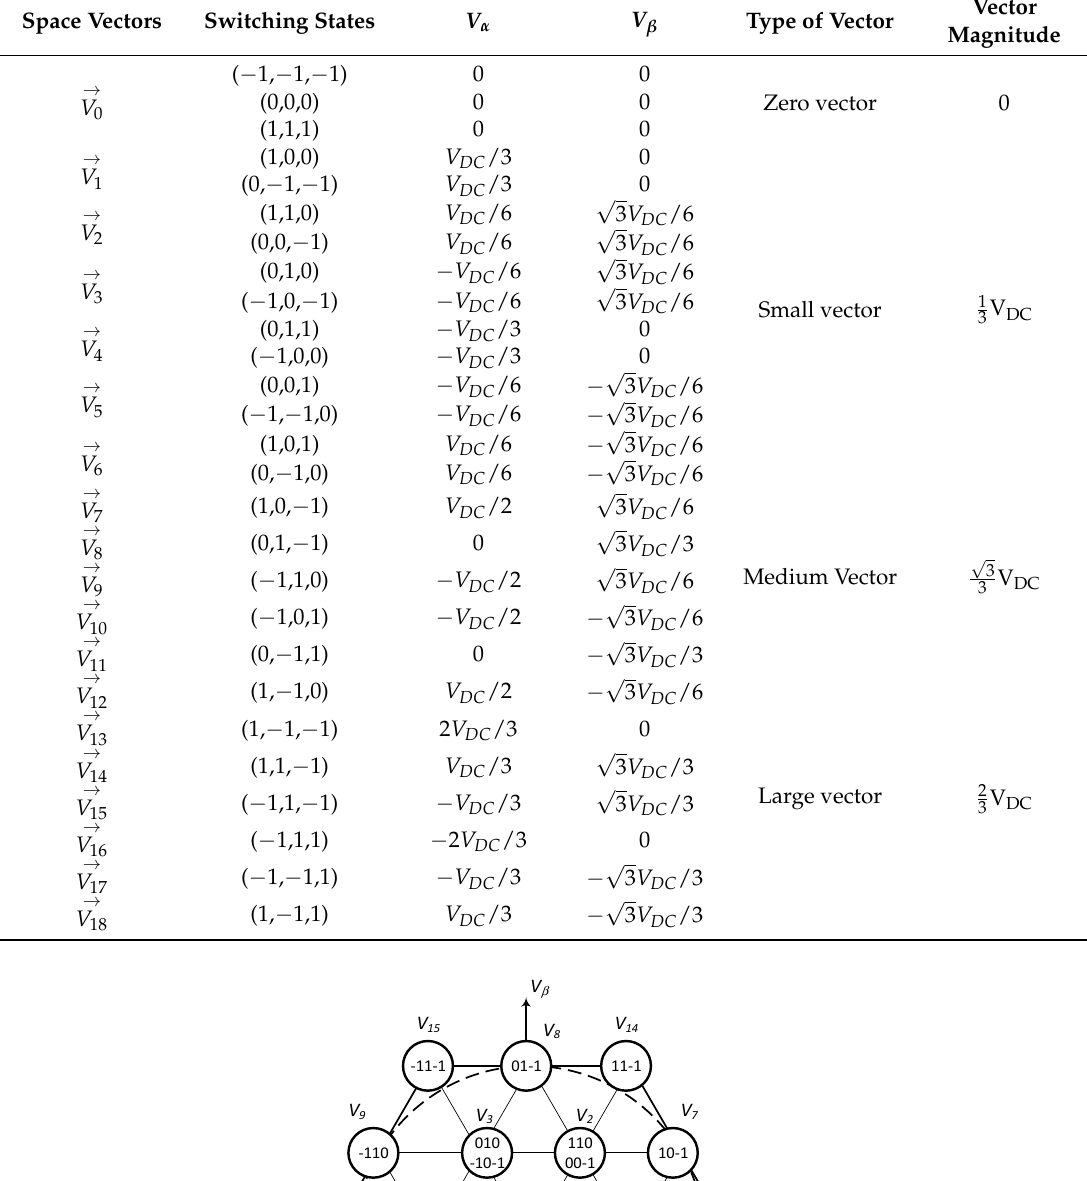
Table 4. Space vectors, switching states and type of vectors.